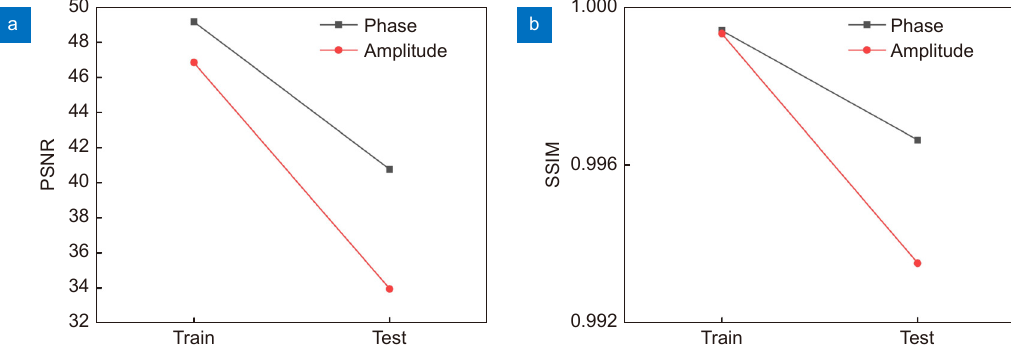
Fig. 13 | PSNR and SSIM of the retrieved phase and amplitude data pages in the training and test datasets: ( a ) PSNR and ( b ) SSIM.